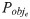
Contour graphs of the reward-mountain surfaces fit to the vehicle and drug data from rat Bechr29.The values of the independent variables along frequency sweeps are designated by red triangles, along price sweeps by blue squares, and along radial sweeps by green circles. The values of the location parameters, Pobje and Fpulsehm, are indicated by blue vertical lines with diamond end points and red horizontal lines with right-facing triangular end points, respectively. The shaded regions surrounding the lines denote 95% confidence intervals. The vehicle data are shown twice, once in the upper-left quadrant and once in the lower right. The dotted lines connecting the panels designate the shifts in the common-logarithmic values of the location parameters of the mountain, which are designated as {ΔPobje, ΔFhm} and plotted in the bar graph in the upper-right panel. The dot-dash cyan lines superimposed on the bars show location-parameter estimates corrected for changes in frequency-following fidelity due to the displacement of the mountain along the pulse-frequency axis. (See section Correction of the location-parameter estimates for changes in frequency-following fidelity in the S1 File.) The 95% confidence intervals are shown in the bar graphs as vertical lines.